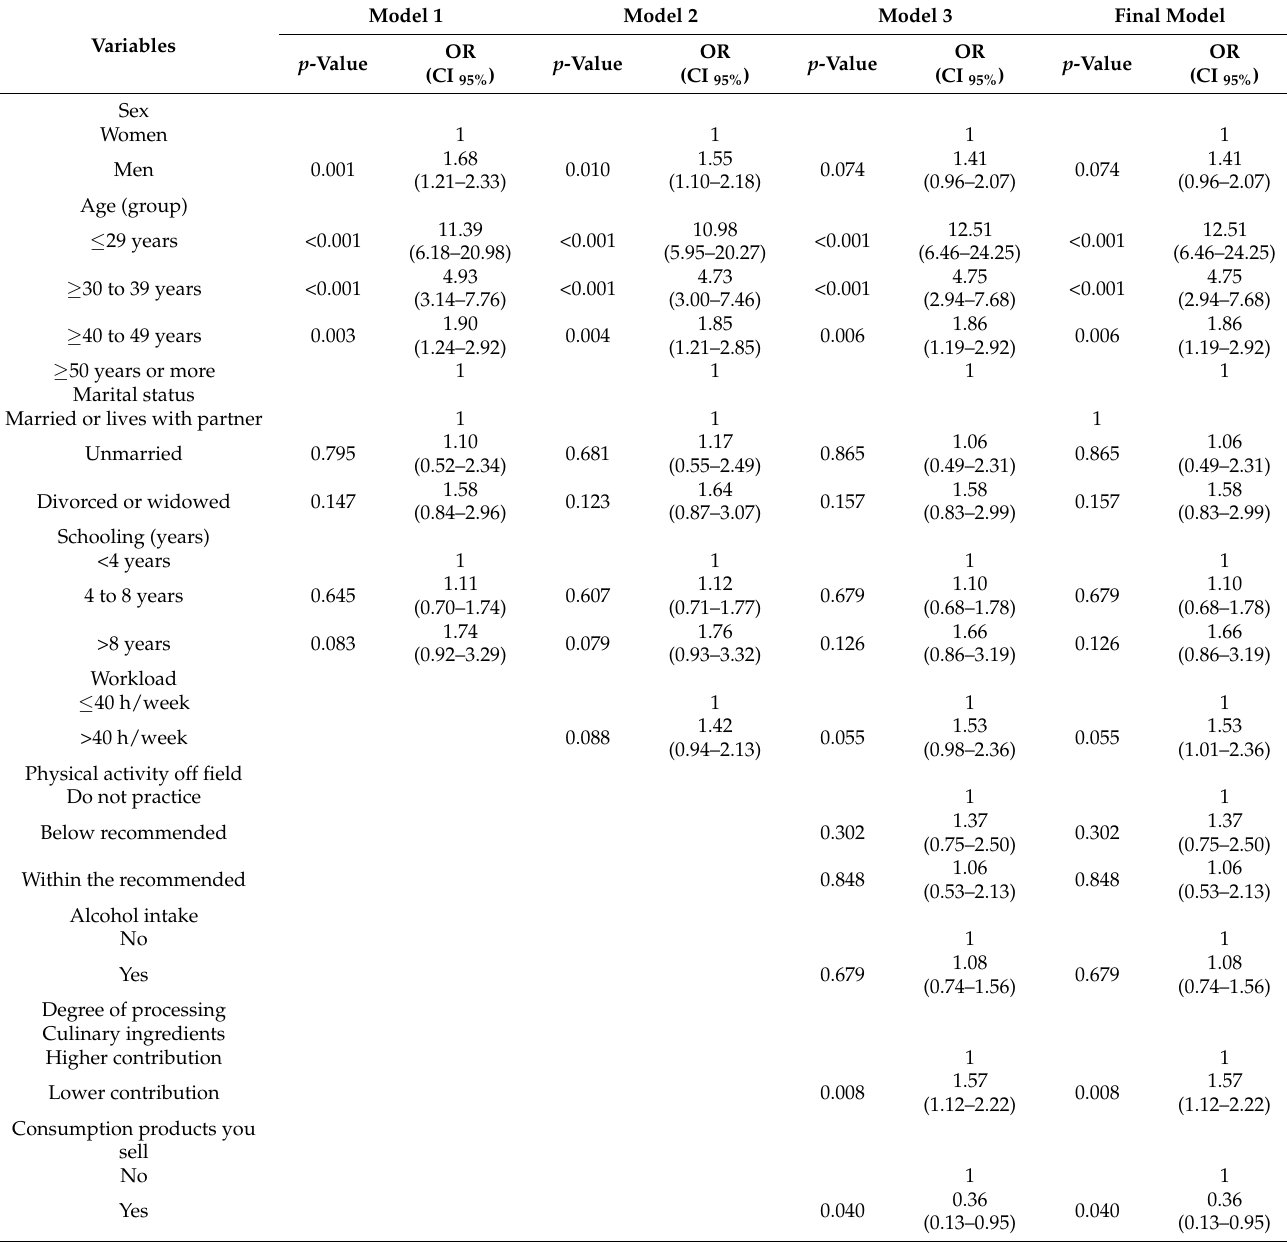
Table 4. Hierarchical logistic regression between the associated variables in the bivariate analysis and the conicity index according to the components of the NCEP-ATP